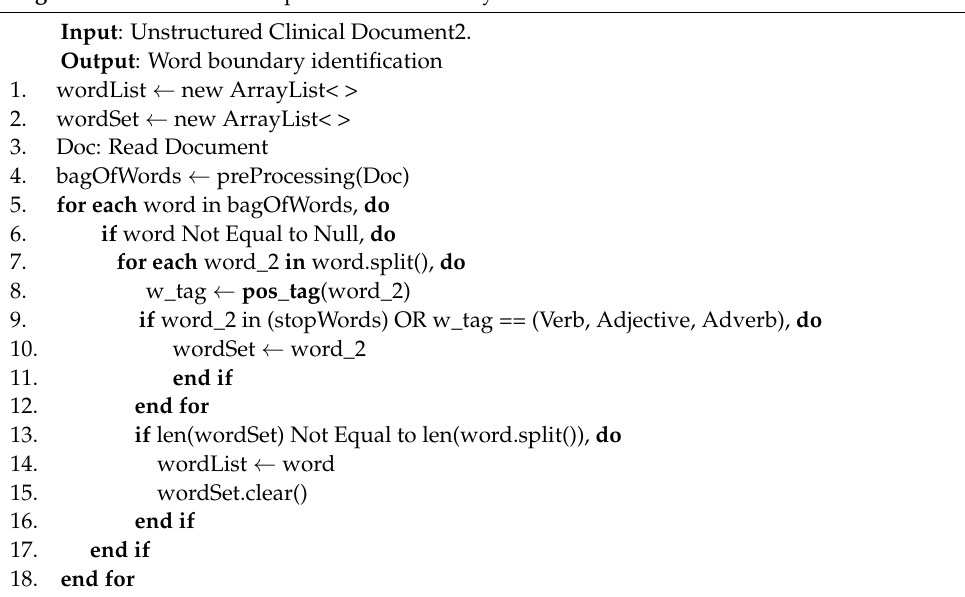
Figure 2. Concept word-boundary identification methodology:identify the word boundary applying to the preprocessing; and map each word to the UMLS. Algorithm 1 : Clinical concepts—word-boundary